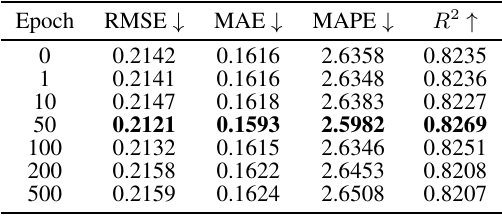
Table 4. Results of using region embeddings learned from MVGNN of different training